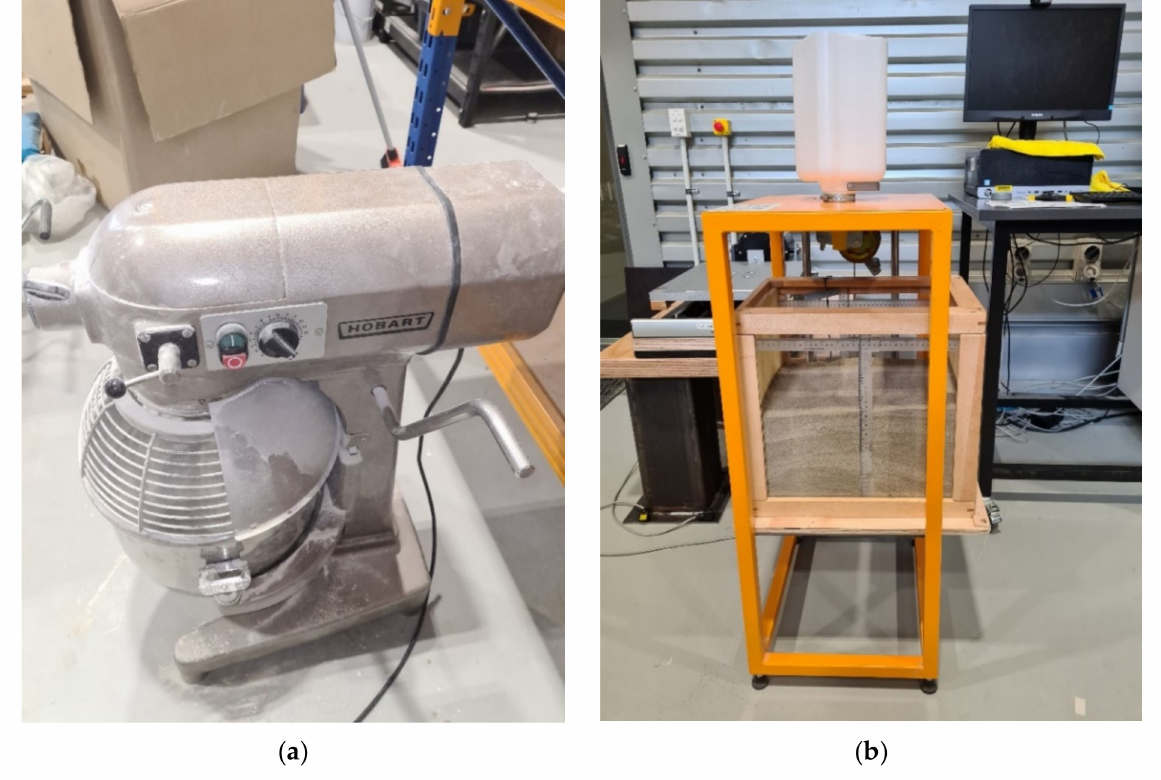
Figure 6. Sample preparations for shaking table experiment. ( a ) Dry mixing of east coast sand and kaolinite. ( b ) Dry pluviation of soil samples into the instrumented soil